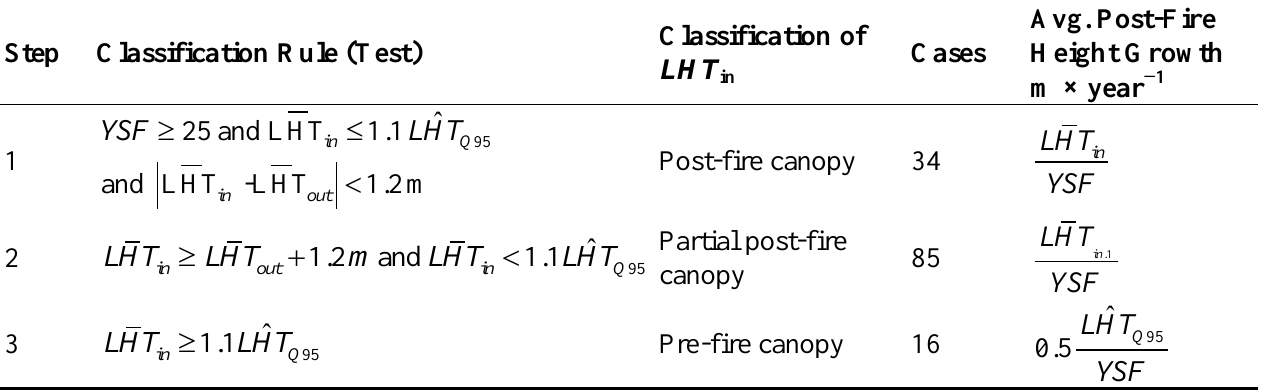
Table 1. Classification of 135 (out of 153) unimodal distributions of LHT post-fire canopy heights when the empirical distribution of LHT single mode. See text for a definition